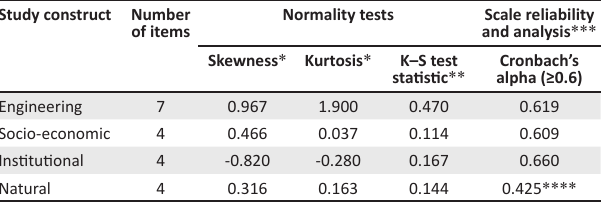
TABLE 1: Normality and reliability of study constructs. Study construct Number of